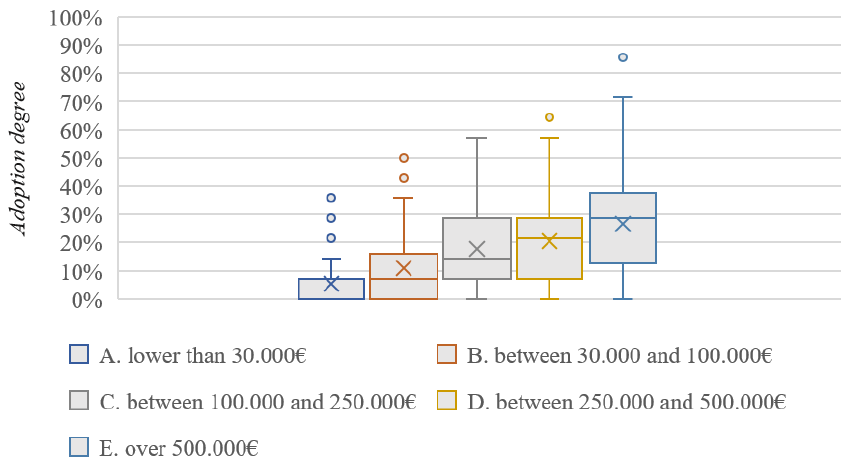
Figure 7. Boxplot graph of the adoption rate depending on company size (revenue).